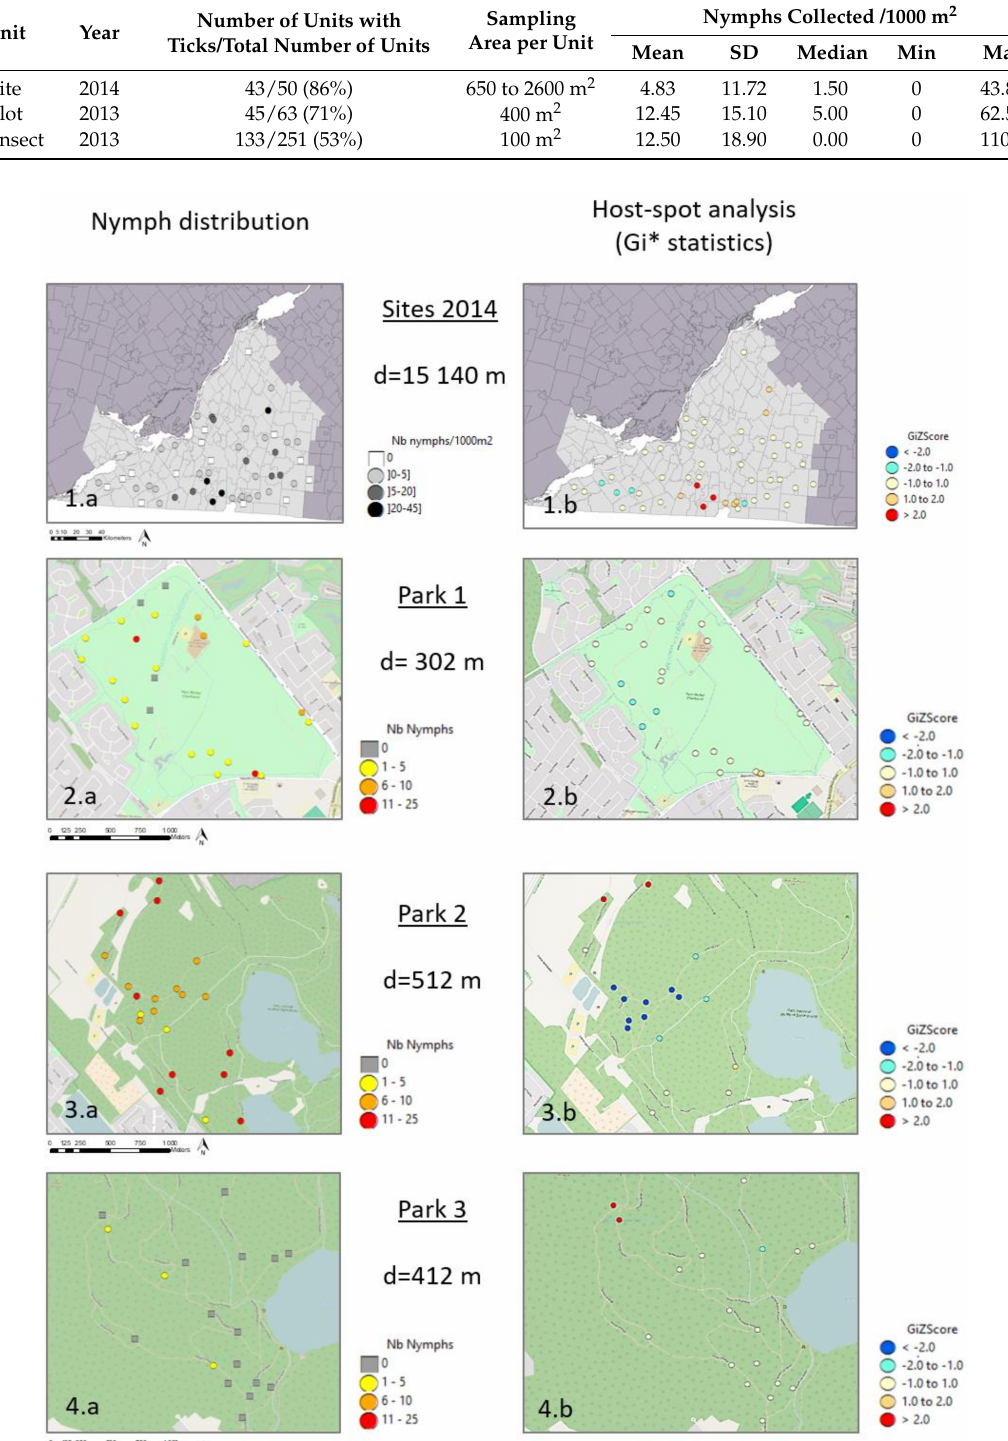
Figure 2. Density of host-seeking I. scapularis nymphs ( 1a – 4a ) and hot spot analysis ( 1b – 4b ) to detect local clusters of nymph density at site and plot scales. Moran’s I correlogram was used to determine the distance (d) used in the Gi* statistics. Significant hot spots (z-score > 2) are shown in red and significant cold spots (z-score < 2) in